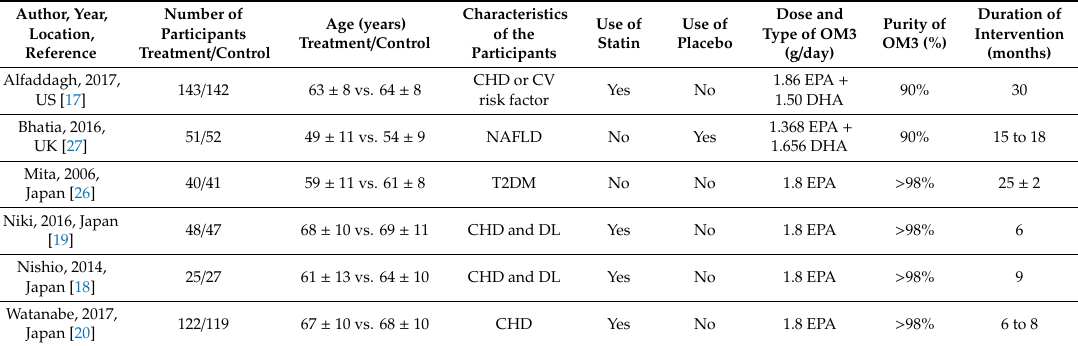
Figure 1. PRISMA flow chart of meta-analysis. Table 1. Characteristics of the included trials.